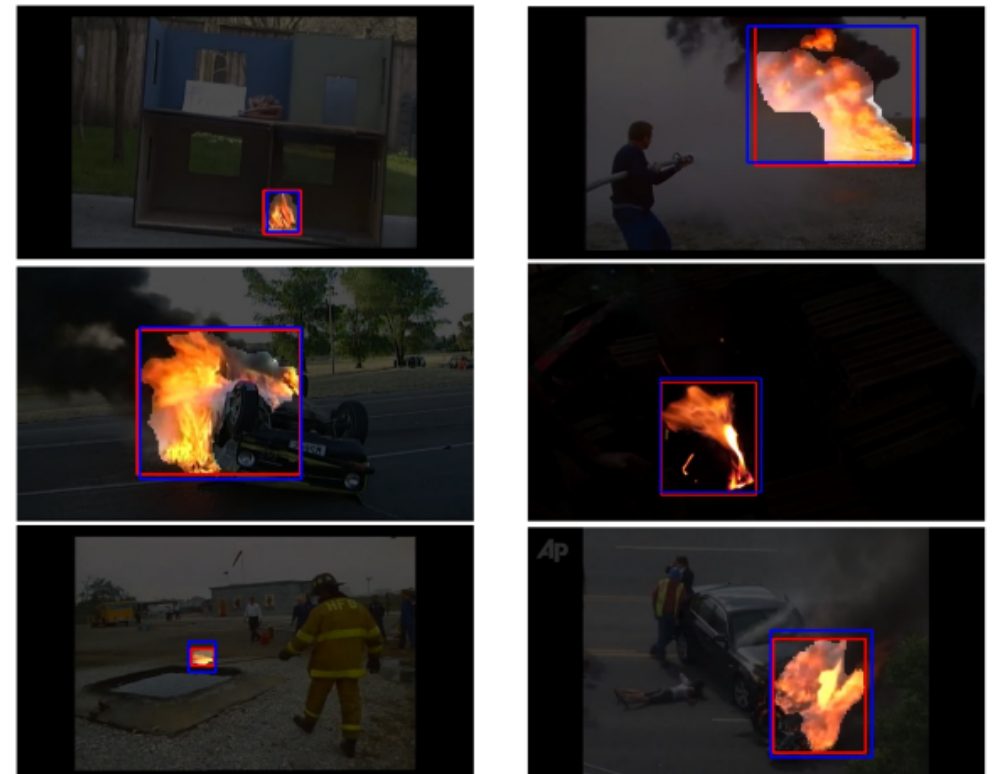
Figure 8. This figure illustrates qualitative results from the testing set. Red rectangle: prediction, blue rectangle: ground